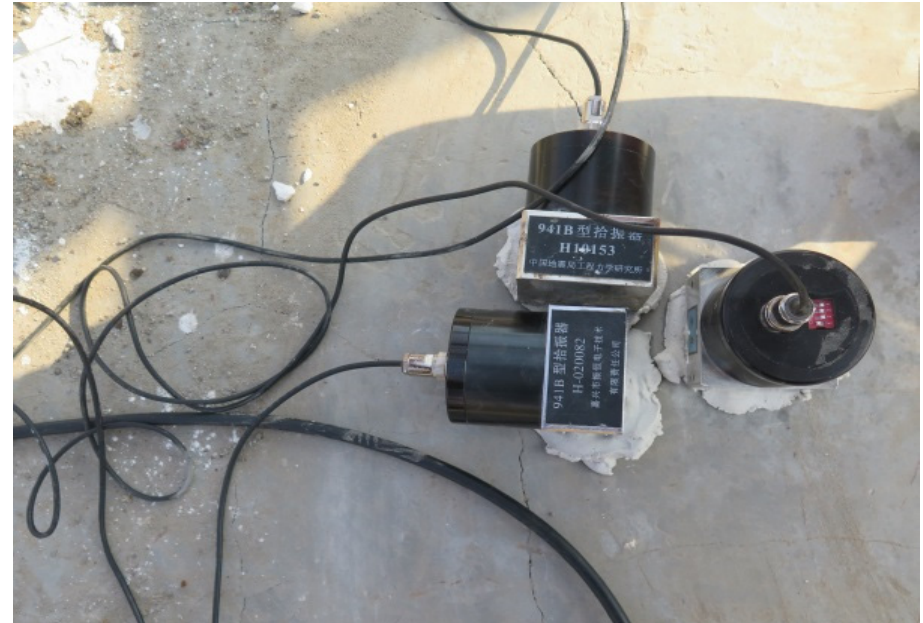
Figure 10. Sensors used in the test.